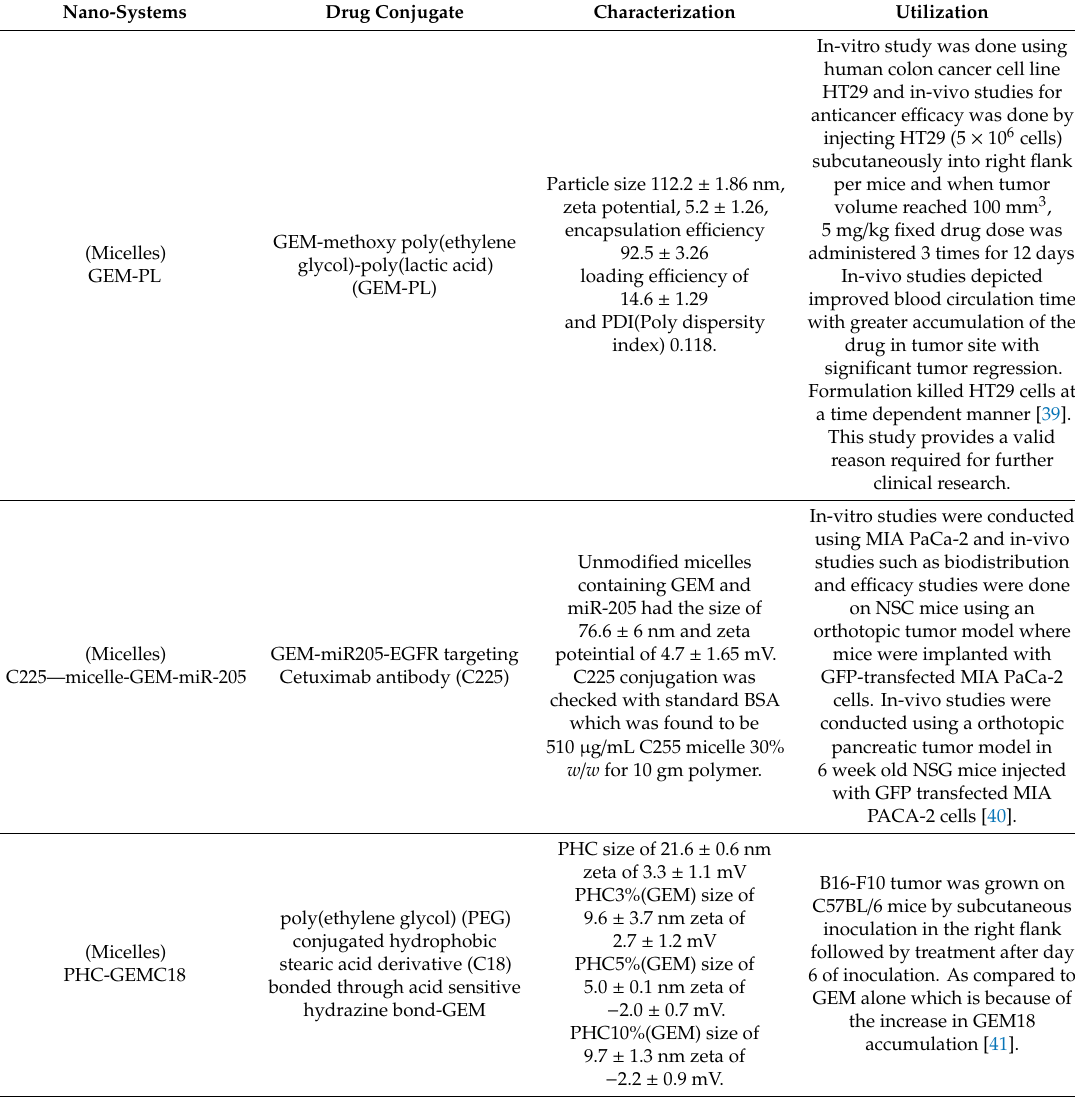
Table 1. Various types of nanosystems at a pre-clinical step for optimizing and inducing the synegistic action of drugs in pancreatic